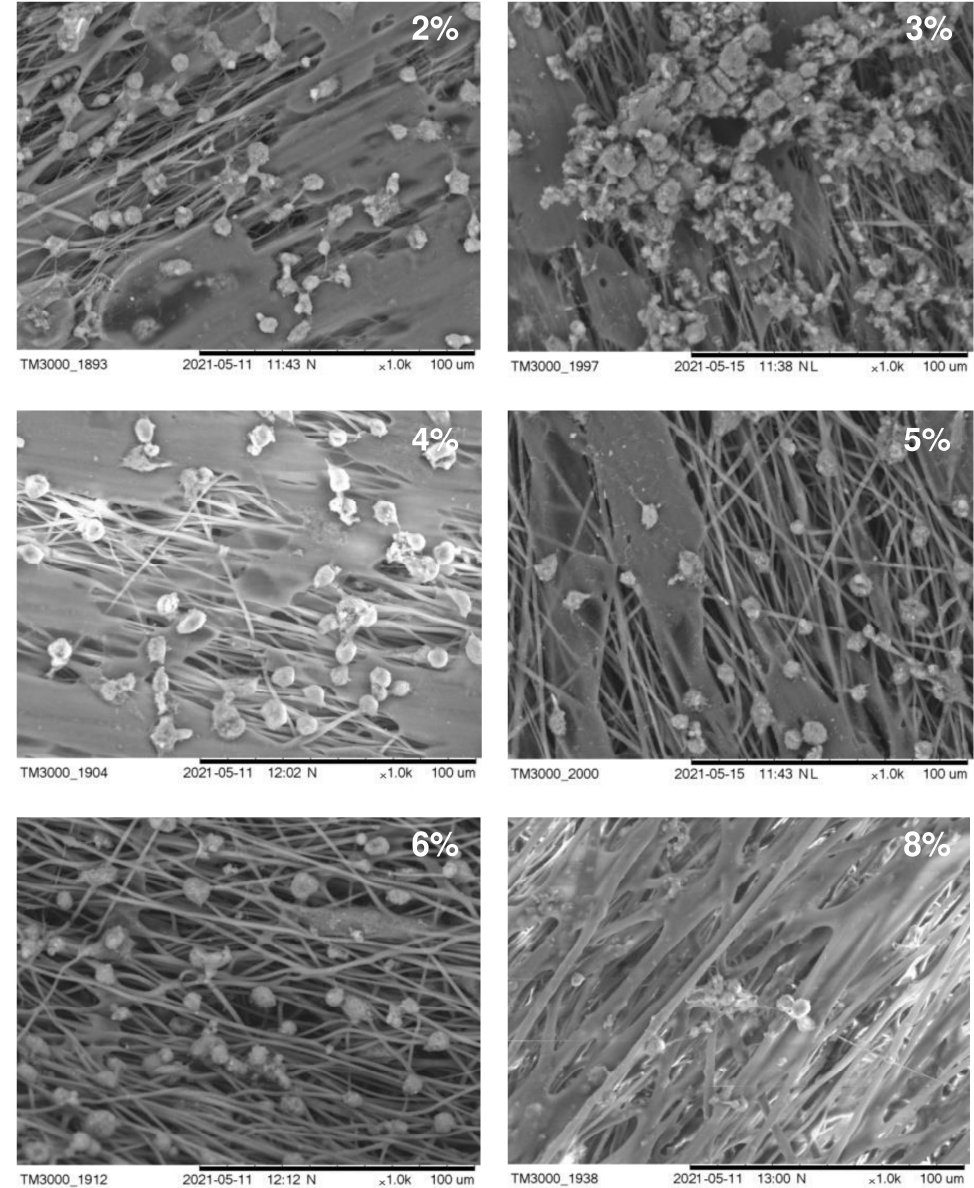
Figure 4. SEM images of NIH 3T3 mouse fibroblasts cultured on nanomembranes obtained by electrostatic molding from P(3HB) solutions of various concentrations.